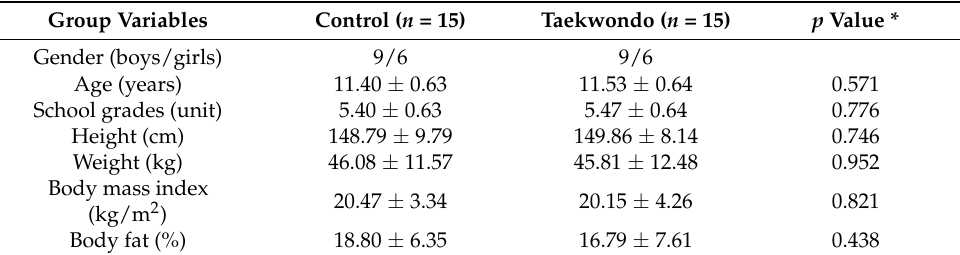
Table 1. Physical characteristics of the subjects at